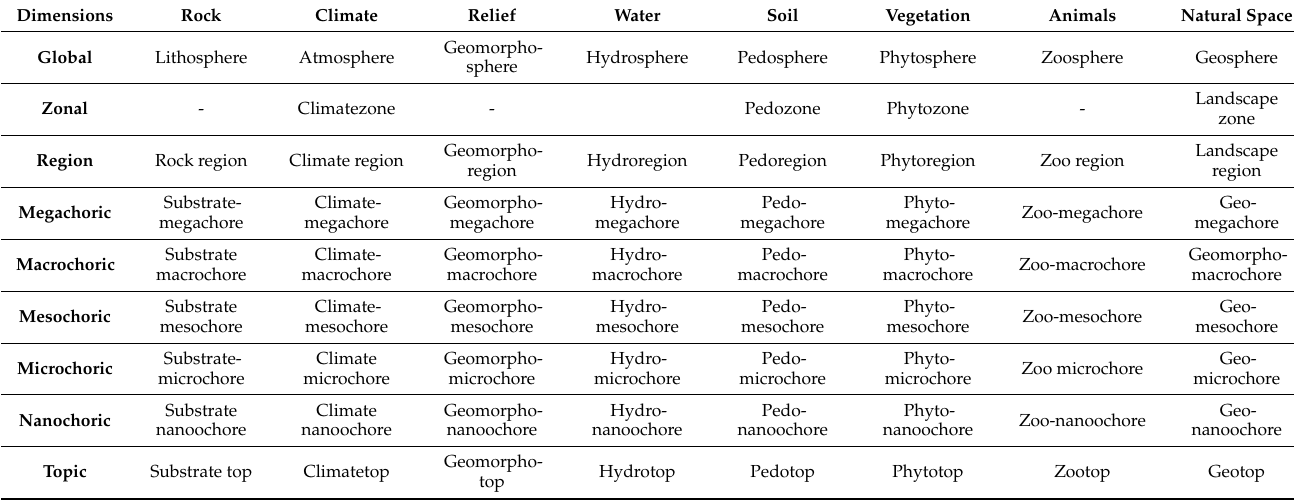
Table 2. Dimension-specific units of the natural area and its components (modified after Sandner, 2015)